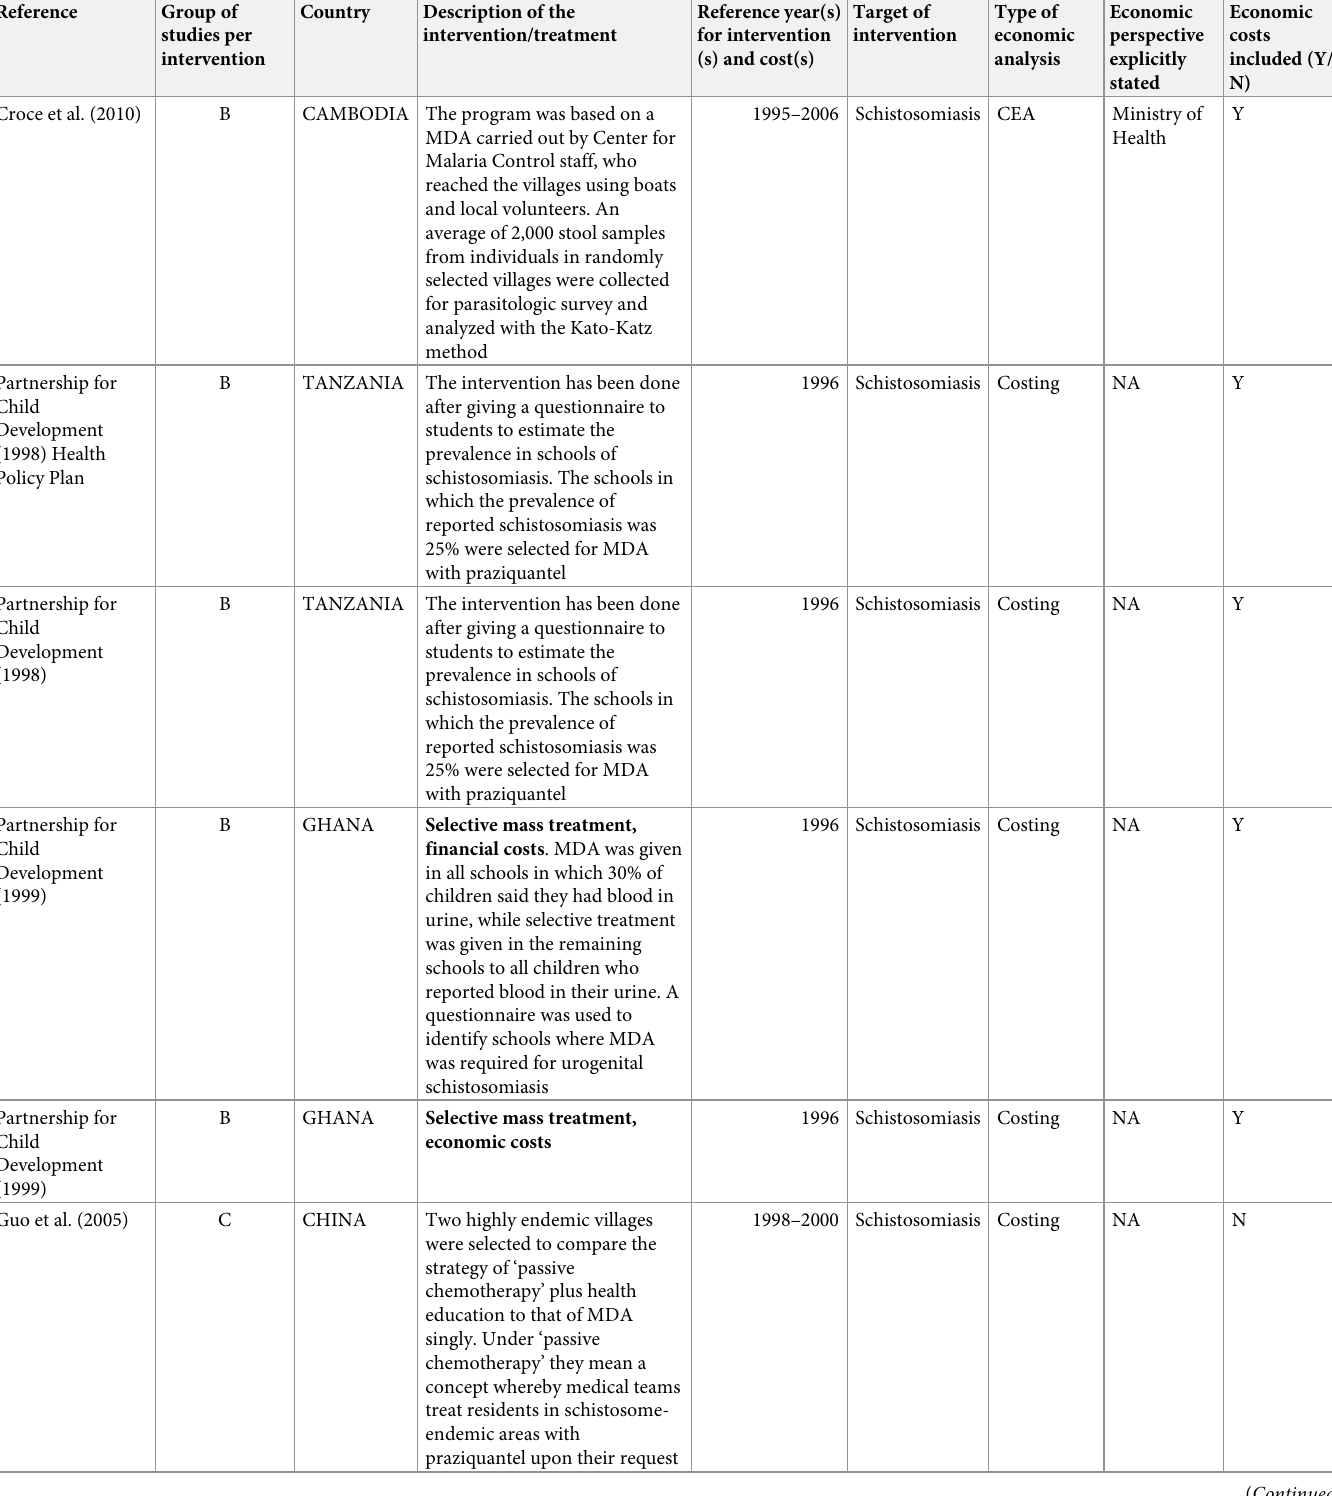
Table 2. List of costs analyses of group B (i.e., preventive chemotherapy plus an individual test to identify at-risk population) and group C (test-and-treat interven- tions) and their main characteristics.